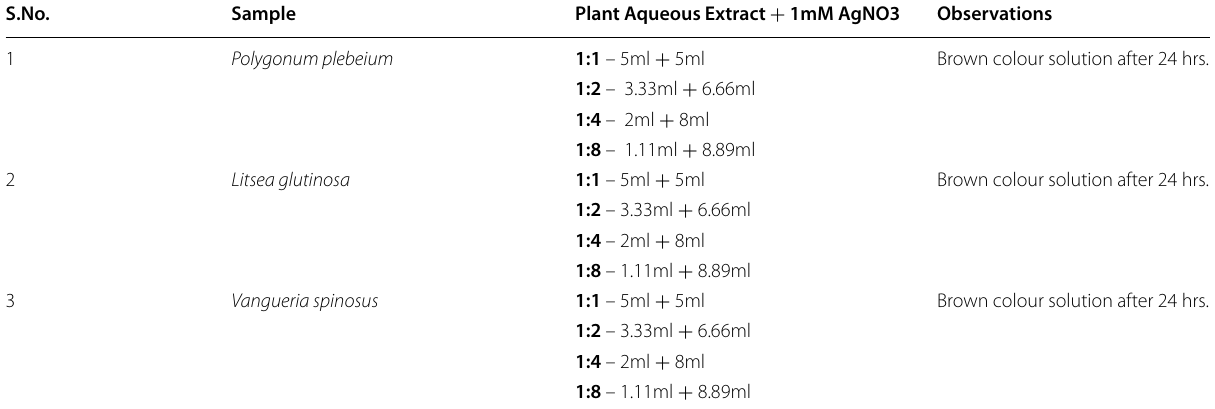
Table 2 List of selected plants Extract with AgNO3 in different ratio